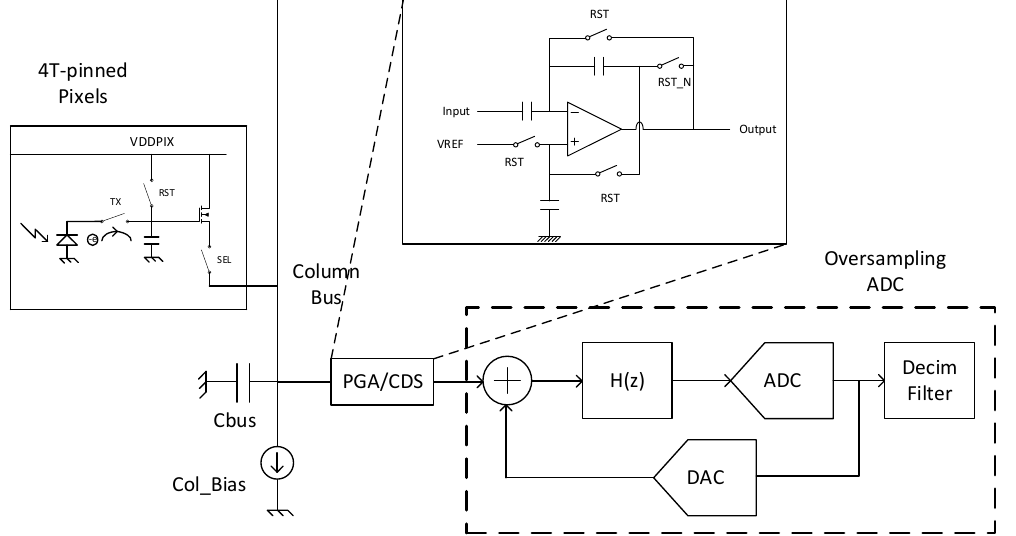
Figure 2. Simplified CMOS image sensors (CIS) entire column readout structure. Additional emphasis to the programmable gain amplifier (PGA)—performing the correlated double sampling (CDS), and to the analog-to-digital converter (ADC) driver circuit implementation—requiring a single-bit built-in digital-to-analog converter (DAC). The pixels and the readout circuits work as follows: while a specific row of pixels is addressed (with the pixel select—SEL control signal switched-on), first, the pixel reset level (pixel supply-VDDPIX) is readout through the in-pixel source follower (SF). This